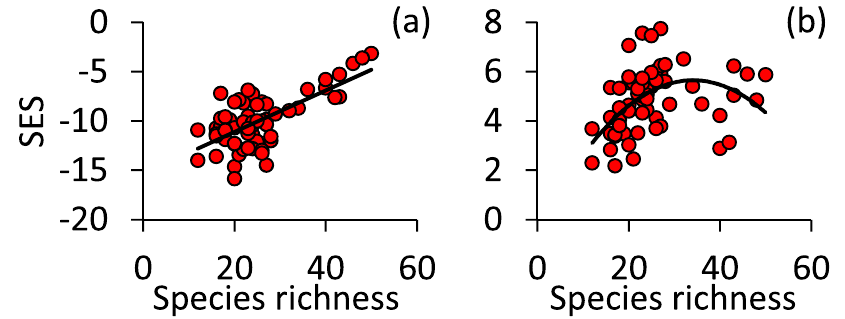
Figure 3. Dependences of standardized effects sizes (SES based on the equiprobable-equiprobable null model) of the C-score ( a ) and NODF ( b ) on species richness. Linear regression in ( a ) Linear OLS regression in a: r 2 = 0.46 (P(F 1,61 ) < 0.001, quadratic OLS regression in b: r 2 = 0.21 (P(F 1,61 ) <